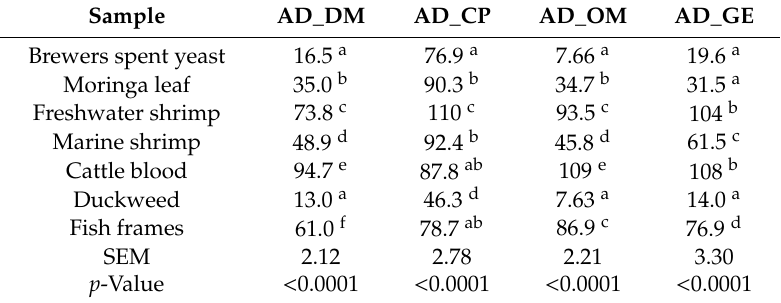
Table 5. Apparent digestibility of test ingredient (AD, %) dry matter (DM), crude protein (CP), organic matter (OM) and gross energy (GE) in Nile tilapia juveniles, determined on faeces collected by siphoning or